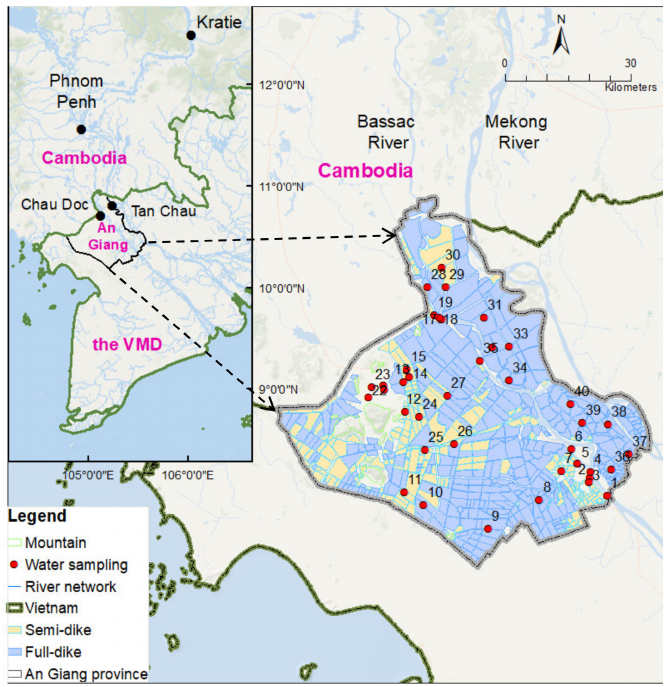
Figure 2. Study area and water sampling sites in An Giang, the Mekong Delta in